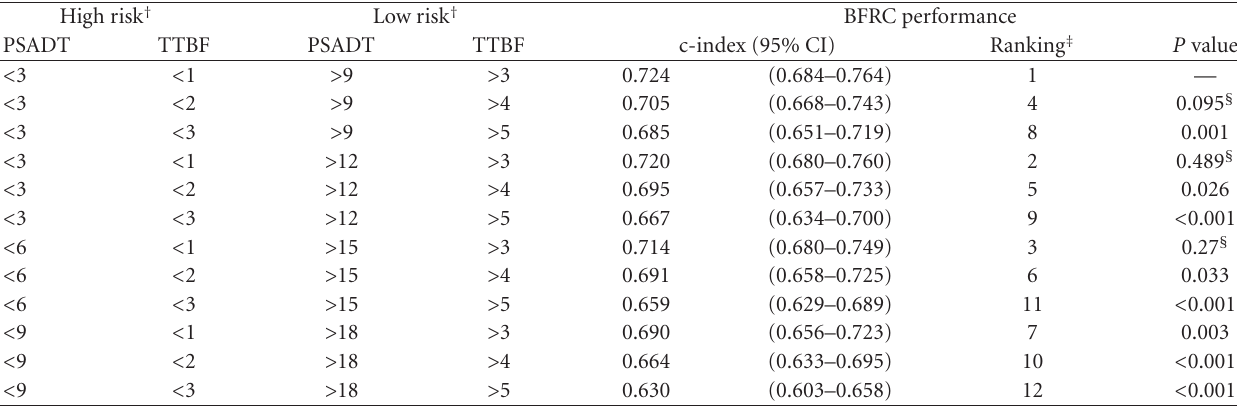
Table 1: Evaluation of 12 “range finding” post-biochemical failure risk categorization (BFRC) schemes in univariable competing risk models for prostate cancer-specific mortality (PCSM) after biochemical failure based on historical prognostic cutpoints for PSA doubling time and time to biochemical